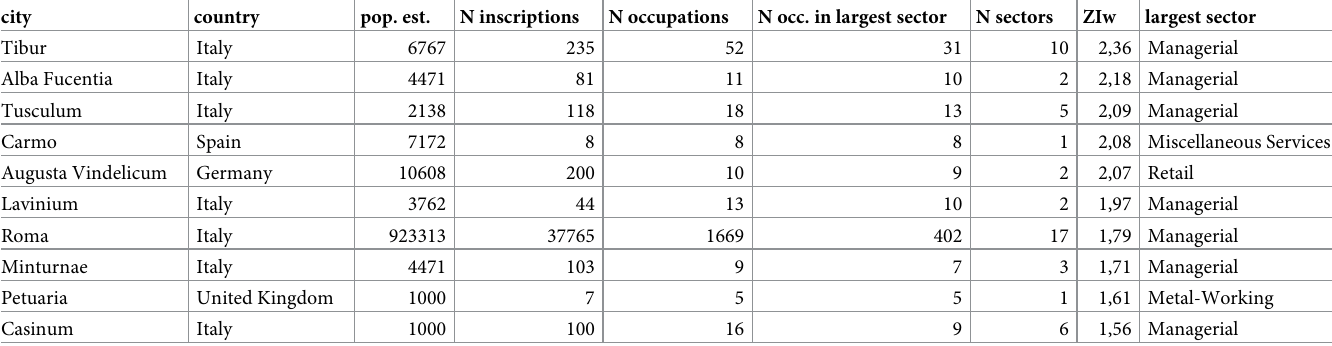
Table 1. 10 cities with the highest ZIw